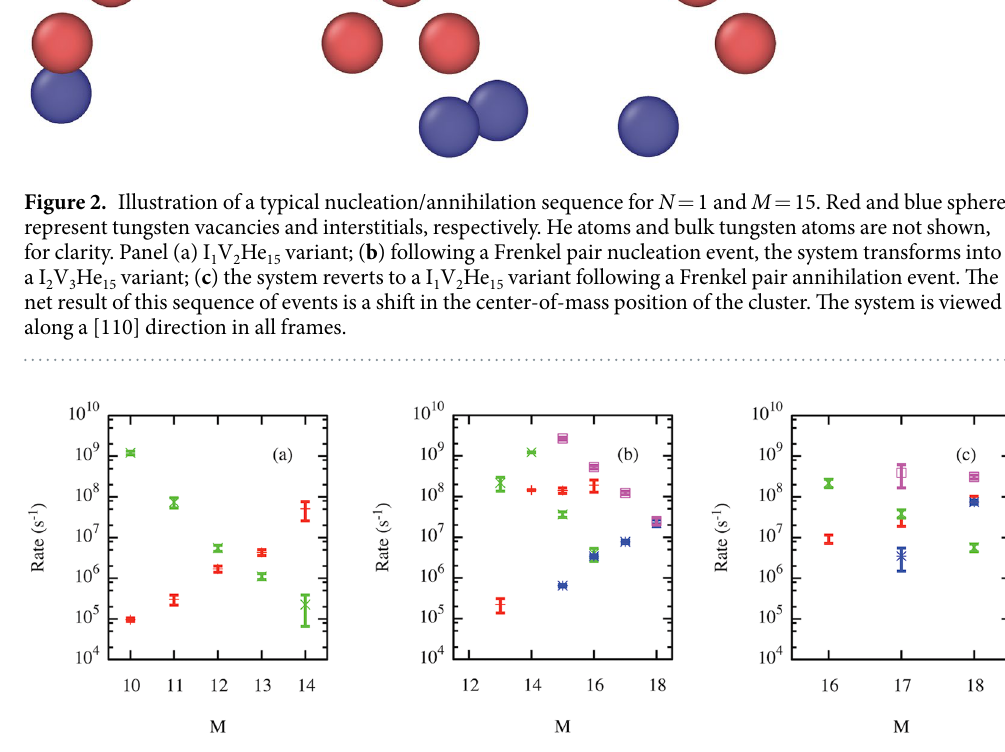
Figure 3. Frenkel pair nucleation and annihilation rates at T = 1000 K as a function of M . Red crosses: nucleation rate for N = 1; Green x: annihilation rate for N = 1; Blue triangles: nucleation rate for N = 2; Magenta squares: annihilation rate for N = 2. ( a ) transition rates between N + L = 1 and 2; ( b ) transition rates between N + L = 2 and 3; ( c ) transition rates between N + L = 3 and